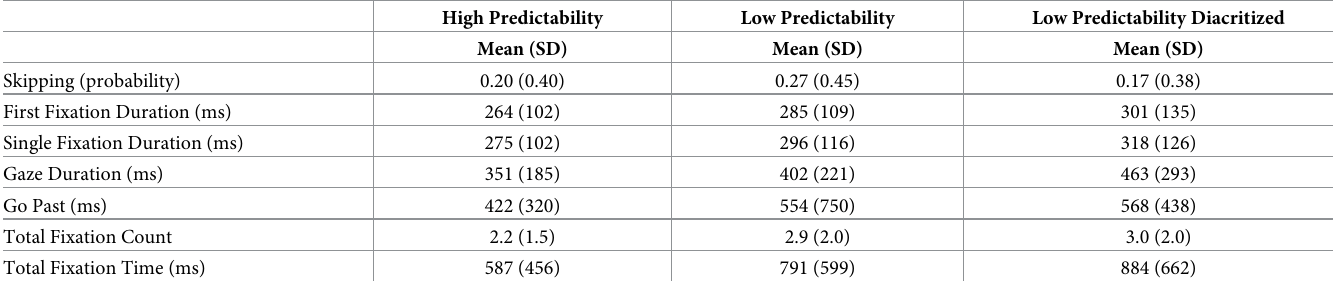
Table 5. Descriptive statistics of eye movement measures (experiment 3 –word predictability and